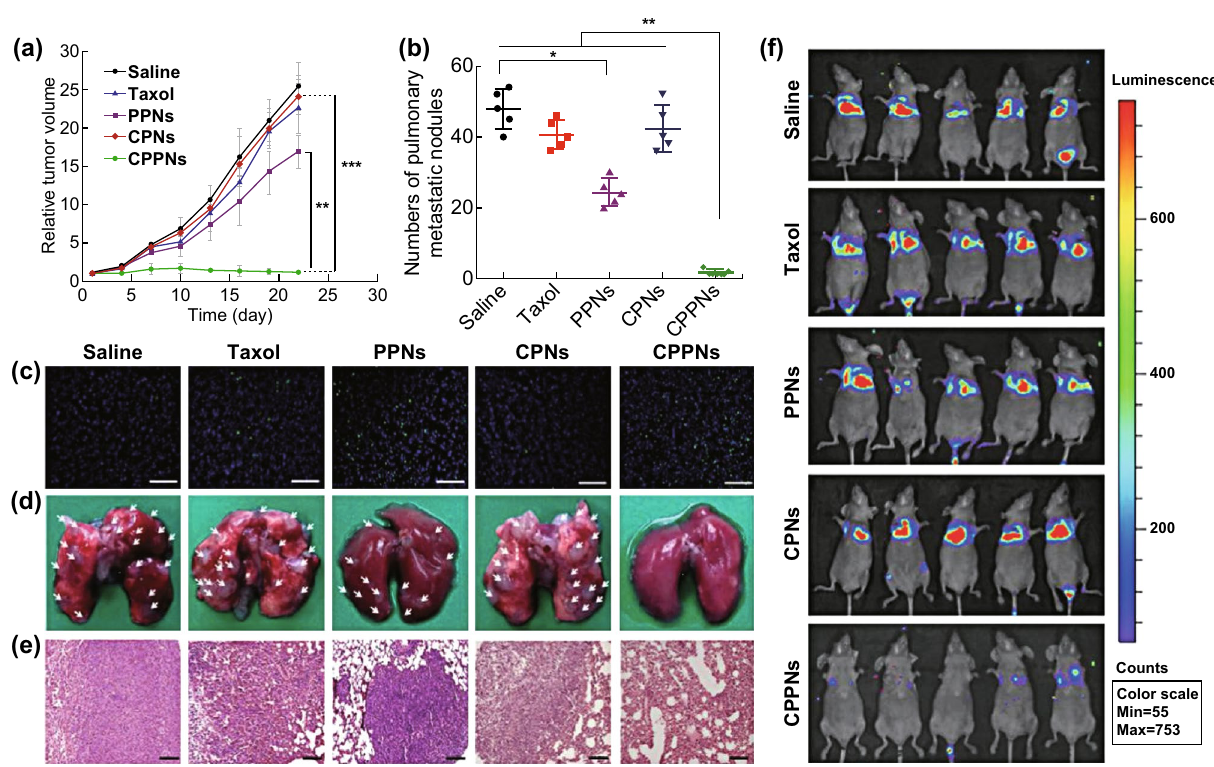
Fig. 12 a – e In vivo effects of CPPNs in mice implanted with 4T1 tumors. a Tumor‑growth and b lung metastases in differently treated mice. c Tumor TUNEL staining. Scale bar = 200 μm. d Lung tissues and e H&E stained lung tissues following experimental termination. Scale bar = 100 μm. White arrows indicate metastases. f In vivo bioluminescent imaging of mice in an i.v. 4T1 metastatic model. Data are mean ± SD ( n = 5). Statistical significance: *p < 0.05, **p < 0.005, and ***p < 0.0005. Adapted from Ref. [141] with